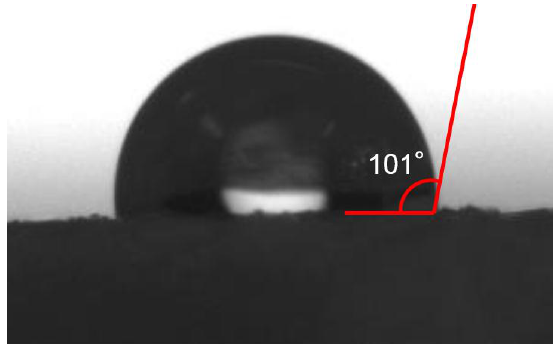
Figure 5. Contact angle made by water on a PVDF-coated flat SLS substrate.